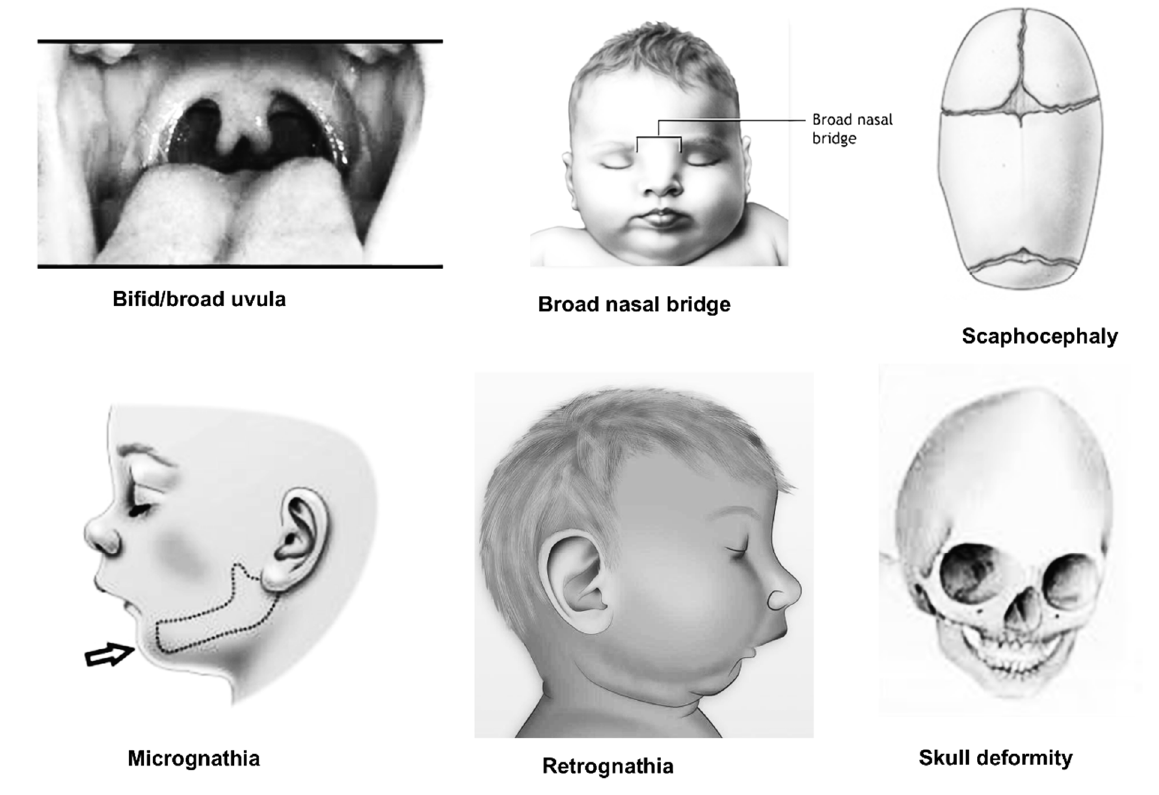
Figure 2. Common oral features found in MFS (Courtesy of Dr. M. K. Alam).